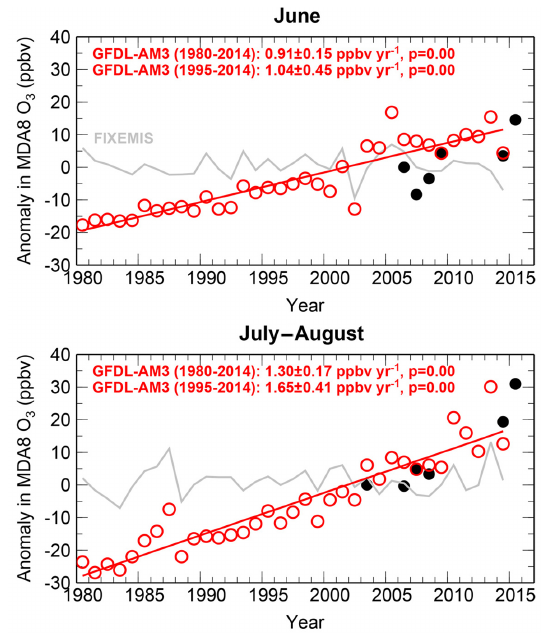
Figure 8. Comparison of ozone trends at Mt. Tai. (a) Anomalies in the June average of MDA8 O 3 from 1980 to 2015 as observed (black dots) and simulated by the GFDL-AM3 model with time- varying (red circles) and constant anthropogenic emissions (gray lines). (b) Same as panel (a) but for the July–August average. The model is sampled in the surface level. The linear trends over 1980– 2014 and 1995–2014, including the 95% confidence limits and p- values, are